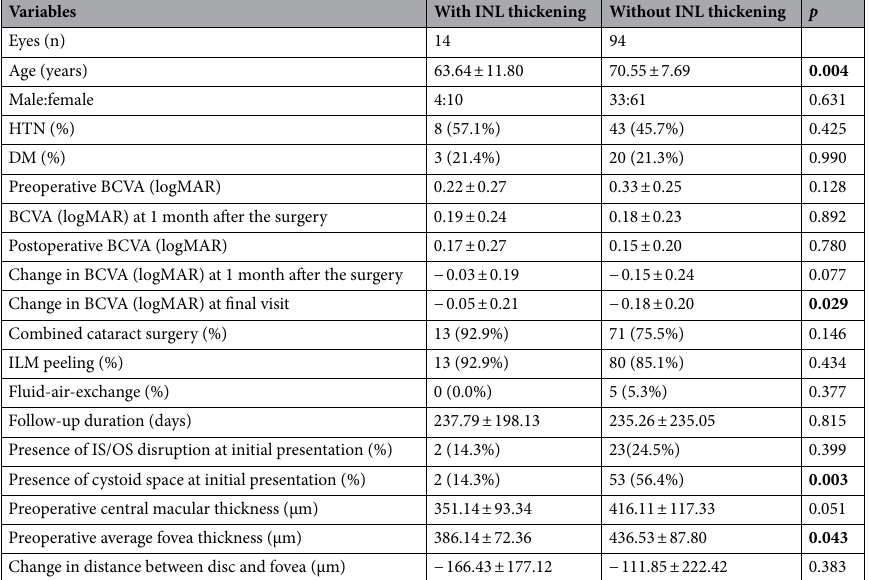
Table 2. Demographics and clinical characteristics of epiretinal membrane patients with and without progressive nasal inner nuclear layer thickening after the surgery. INL inner nuclear layer, HTN hypertension, DM diabetes mellitus, BCVA best corrected visual acuity, logMAR logarithm of the minimum angle of resolution, ILM internal limiting membrane, CMT central macular thickness, IS/OS inner and outer segment. Significant values are in [bold].